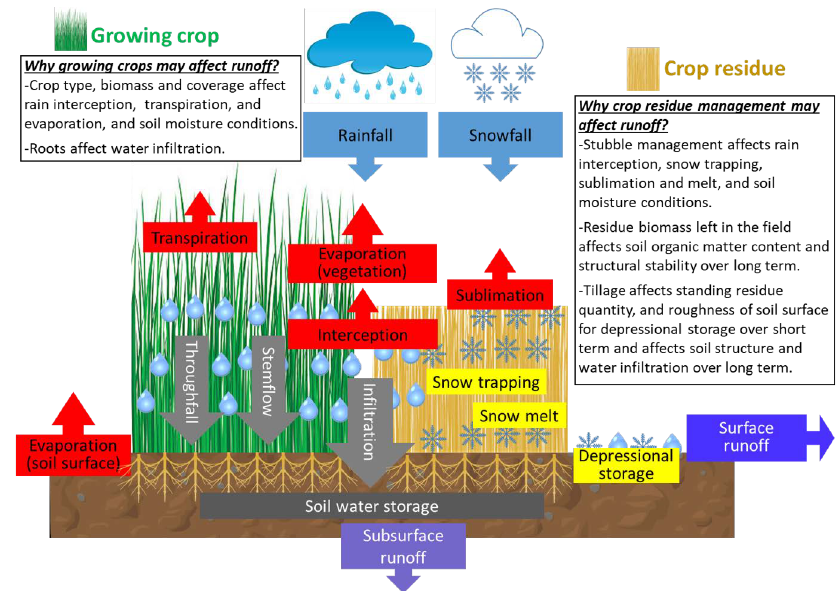
Figure 1. A diagram of the water cycle and how management of growing crops and crop residues affects runoff in the Canadian Prairies, where both snowfall and rainfall derive runoff, and surface runoff overwhelms subsurface runoff. In field research, interception, transpiration and evaporation are often measured together and simply defined as evapotran- spiration.